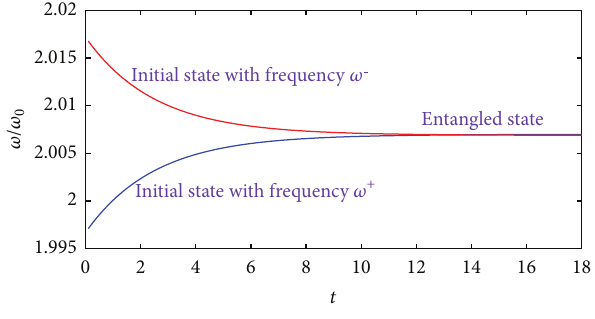
Figure 2: Plot of the dispersion relation versus time. Red curves for the spin branches with frequency 𝜔 − ; blue curve for the spin branches with frequency 𝜔 + . Both curves entangled at a certain time scales in the presence of noise.